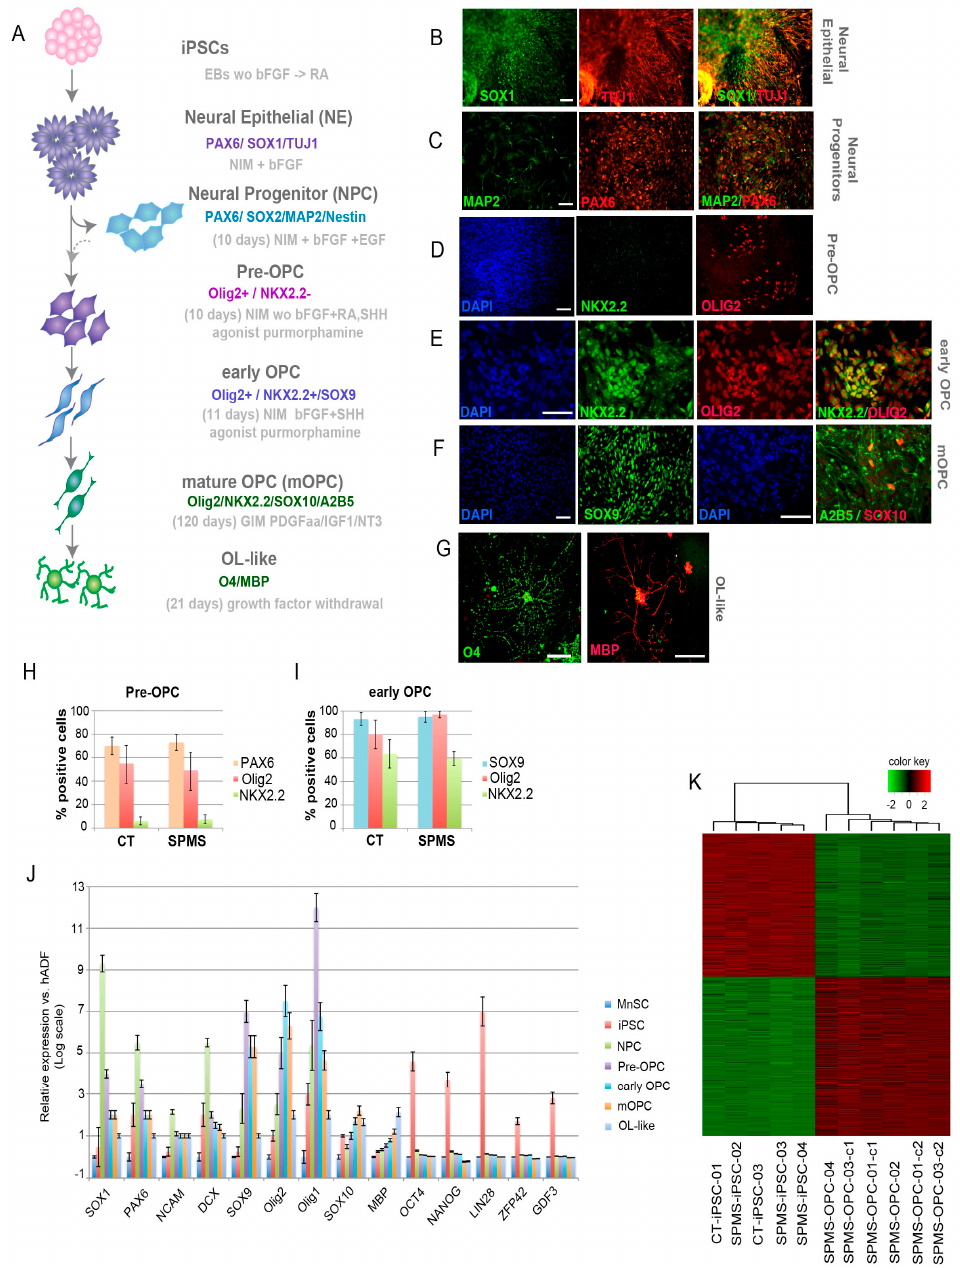
Figure 2. Efficient differentiation of SPMS-iPS cell lines into oligoprogenitor cell fate. ( A ) Schematic protocol for differentiation of hiPSCs into OPC-like cells. Embryoid bodies (EBs) were differentiated from hiPSCs and then differentiated as neuroepithelial (NE) cells in neural induction media (NIM) with bFGF as described in experimental procedures. ( B–F ) Representative immunofluorescence images of SPMS-iPSCs at each of the differentiation stages underlined: ( B ) SPMS-iPSC-derived NE cells at this stage expressing the neuroepithelial markers PAX6 and TUJ1; ( C ) When NE cells are subjected to neural progenitor cell media containing basic fibroblast growth factor (bFGF) and EGF they express PAX6 and MAP2 markers; ( D ) When NE cells are cultured in the absence of bFGF and in the presence of RA and SHH agonist purmorphamine they express the pre-oligo progenitor (pre-OPC) marker Olig2 but not NKX2.2; ( E ) After further culture with bFGF and purmorphamine without RA, proliferative OPC-like cells show Olig2 and NKX2.2. ( F ) Culture of OPC-like cells in glial induction media (GIM) gives rise to mOPC with SOX9-, A2B5-, and SOX10-positive labeling. ( G ) After growth factor withdrawal, they gave rise to oligodendrocyte-like (OL) cells expressing O2 and MBP markers. ( H,I ). Flow cytometric analysis at pre-OPC ( H ) and early OPC-like ( I ) stages of CT- and SPMS-derived samples, showing the percentage of positive cells for each selected marker. Data are